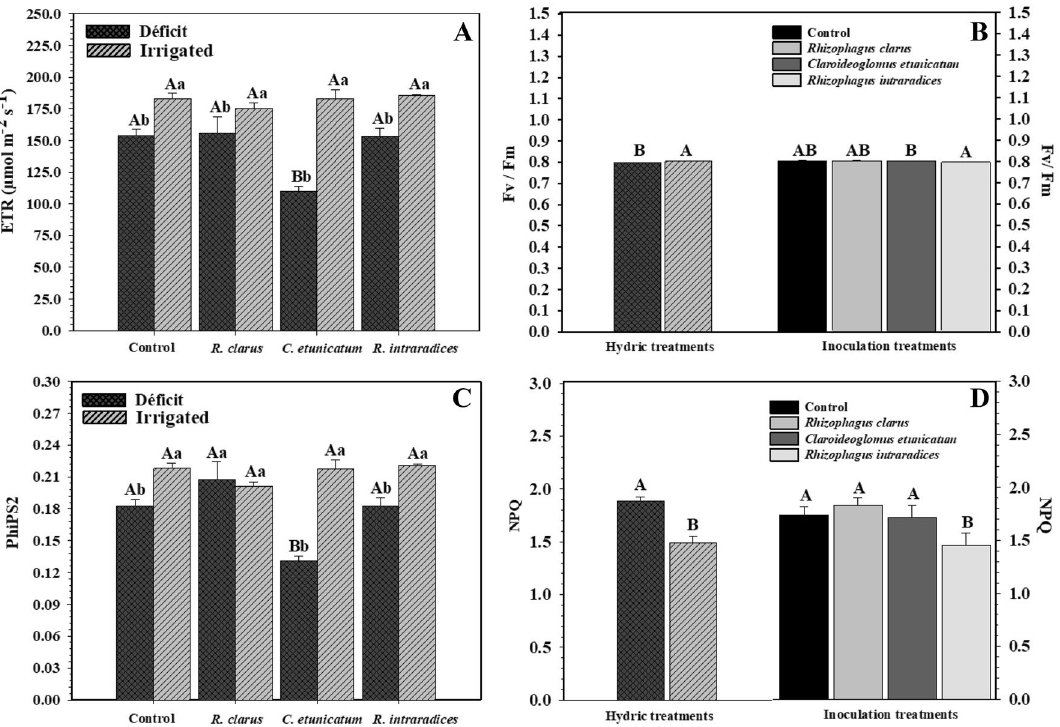
Figure 3. Electron transport [ETR] ( A ), maximum quantum yield of FS II [Fv/Fm] ( B ), effective photochemical efficiency of photosystem II [PhiPS2] ( C ), and nonphotochemical extinction coefficient [NPQ] ( D ) of corn plant s (Zea mays) subjected to different water treatments and inoculation with arbuscular mycorrhizal fungi in the period of water restriction. The bars represent the mean ± standard error of the mean (SEM) ( n = 4). Means followed by the same letter, uppercase among inoculation treatments and lowercase between water treatments, do not differ ( p > 0.05) among themselves by Tukey’s with R. intraradices (ROOTELLA BR) showed a difference, in which the hydric deficit plants had a lower value than irrigated plants. The chlorophyll b concentration showed no difference between the inoculation and water treatments. In the Cla/Clb ratio (Fig. 4B), the lowest mean value was for the inoculated with R. intraradices (ROOTELLA BR) but did not differ from the other treatments. The total chlorophyll concentration (Clt) differed among treatments (Fig. 4C). For the WD treatment, only those inoculated with R. intraradices (ROOTELLA BR) differed, presenting a lower mean value of Clt. In the irrigated treatment, the highest mean value was for noninoculated plants but did not differ from those inocu- lated with R. clarus and R. intraradices (ROOTELLA BR), while the lowest value was for those inoculated with C. etunicatum . Observing the water treatments within the different inoculations, only those not inoculated and inoculated with R. intraradices (ROOTELLA BR) differed, in which the irrigated treatments were higher than those of HD. In the carotenoid (Fig. 4D), the lowest concentration was observed in those inoculated with C. etunicatum and R. intraradices (ROOTELLA BR), with an average value of 9.06 μg cm −2 for both, but did not differ from the other treatments. The height (Fig. 5A) and stem diameter (Fig. 5B) of the plants showed differences separately only for the hydric treatments. The height of HD plants was lower (31.66 cm) than that of plants kept under irrigation (39.83 cm) (Fig. 5A). The stem diameter also presented the same response, in which HD plants had an average of 1.20 cm and irrigated plants reached an average of 1.65 cm. The dry weight of the leaves evaluated after reirrigation differed among treatments (Fig. 5C), while HD plants did not differ from each other. For the irrigated treatment, plants inoculated with R. clarus had a lower average dry weight value. Analysing the water treatments within each inoculation, it was observed that all irrigated plants were larger than those of HD. The dry weight of the roots differed only in the hydric treatments (Fig. 5D), in which the dry weight of the irrigated plants was higher than that of the HD plants. The total dry weight differed among treatments (Fig. 5E). HD plants did not differ from each other. In the irrigated treatment, those inocu- lated with C. etunicatum had the highest mean value of total dry weight but did not differ from those inoculated with R. intraradices (ROOTELLA BR) and those not inoculated. The lowest total dry weight value was for those inoculated with R. clarus. Regarding the hydric treatments within the different inoculations, all irrigated treat- ments were higher than HD plants. The first two components explained 54,5% (PC1 40,3% and PC2 14,2%) of the variance, demonstrating the variations in the parameters observed in corn plants and allowing us to observe the relationships between the variables and the hydric and inoculation treatments. Most variables correlated significantly ( p < 0.05) with the